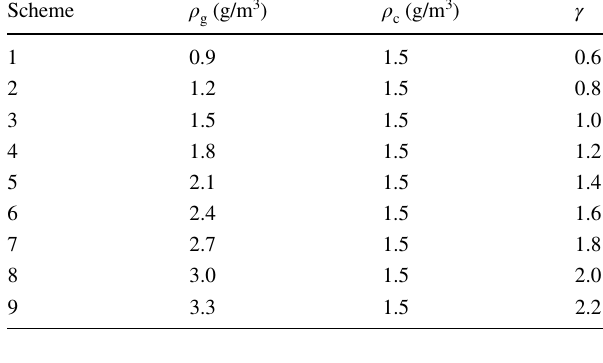
Table 2 Parameters for different schemes Scheme